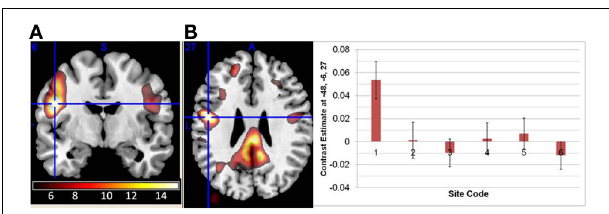
FIGURE 5 | The effects of motion and physiological signal regression on fALFF: The regression step decreased fALFF values throughout most of the gray matter and subcortical areas ( p < 0 . 05, FDR corrected; t > 1 . 7; color bar indicates the t- value range, and slice locations are indicated).